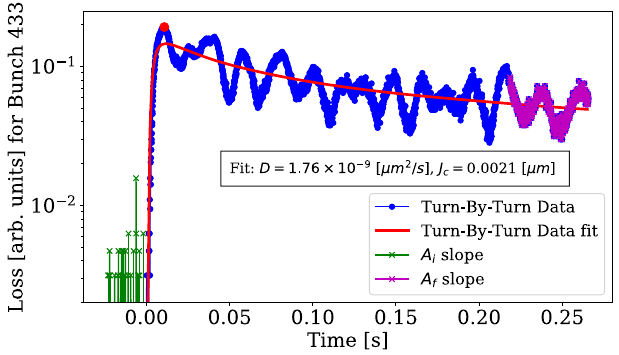
FIG. 6. An example of the fit result (red) for one bunch loss data (blue), recorded by dBLM acquisition mode 2 during fill 7392 reported in Table III. Highlighted green and magenta regions were used to establish the initial ( A